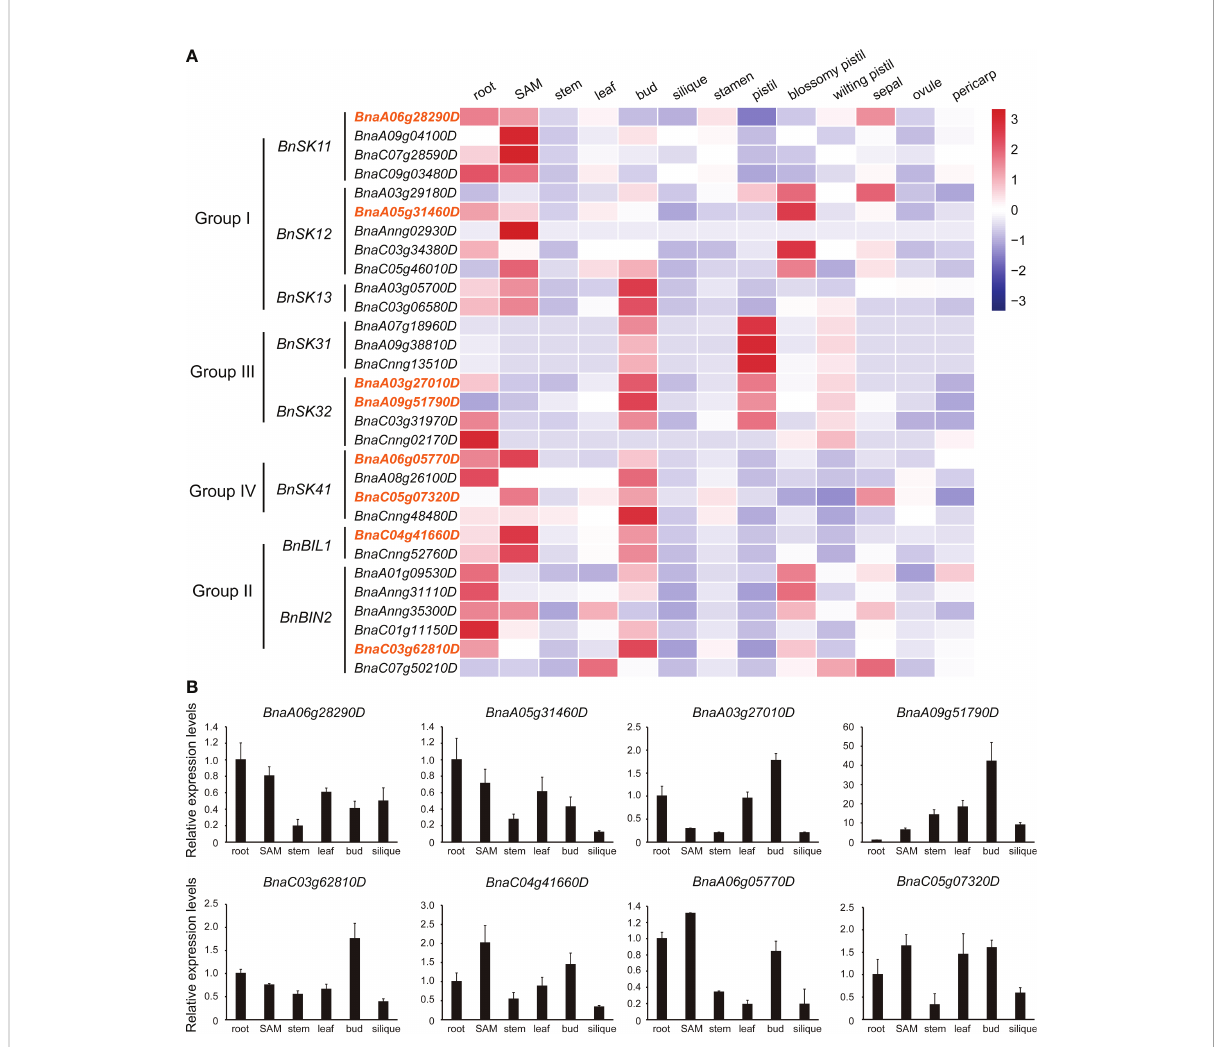
FIGURE 6 Expression pattern of BnGSK3s . (A) Expression pattern of the 31 BnGSK3s in 13 tissues of B . napus cv. ZS11 based on RNA-seq. Bar represents the normalized transformed counts of FPKM. The expression of eight genes marked in orange were veri fi ed by qRT-PCR. (B) Expression patterns of eight BnGSK3s in six tissues of B . napus cv. ZS11 based on